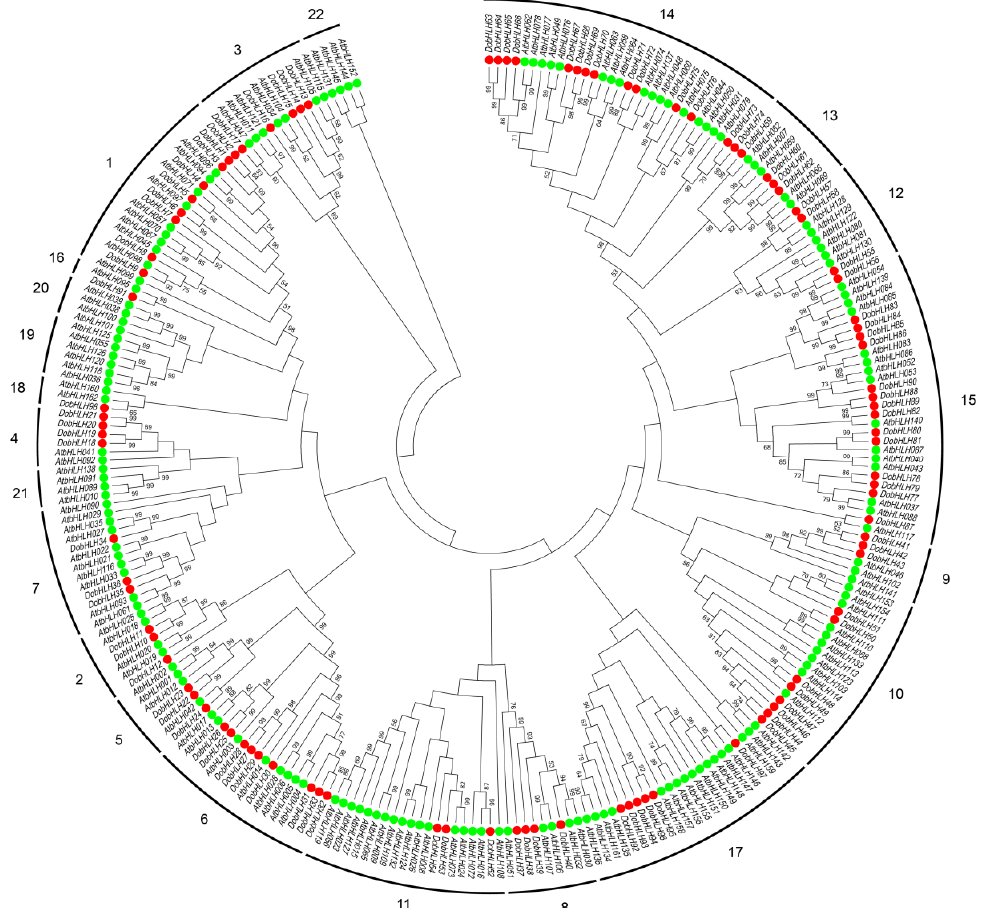
Figure 1. Phylogenetic analysis of bHLH proteins from D. officinale and Arabidopsis. A total of 98 DobHLH proteins and 162 AtbHLH from Arabidopsis (Arabidopsis thaliana) were used to construct the unrooted neighbor-joining (NJ) tree with a bootstrap of 1000 replicates. The bHLH proteins are grouped into 22 clades, and marked in different colors: AtbHLH genes are in green while DobHLH genes are in red.